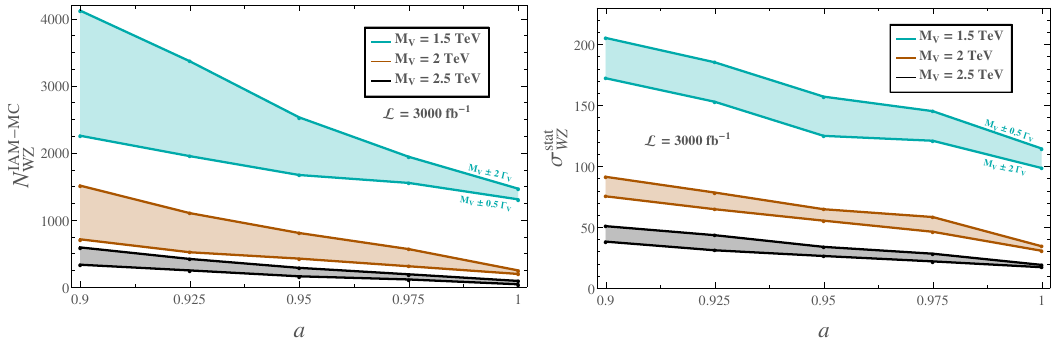
Figure 14 . Predictions for the number of events, N IAM (cid:0) MC (left panel), and the statistical signif- WZ icance, (cid:27) stat (right panel), as a function of the parameter a for = 3000 fb (cid:0) 1 . The marked points WZ L correspond to our selected benchmark points in (cid:12)gure 4. The two lines for each mass are computed by summing events within 0 : 5 (cid:0) V and 2 (cid:0) V , (cid:6) (cid:6)